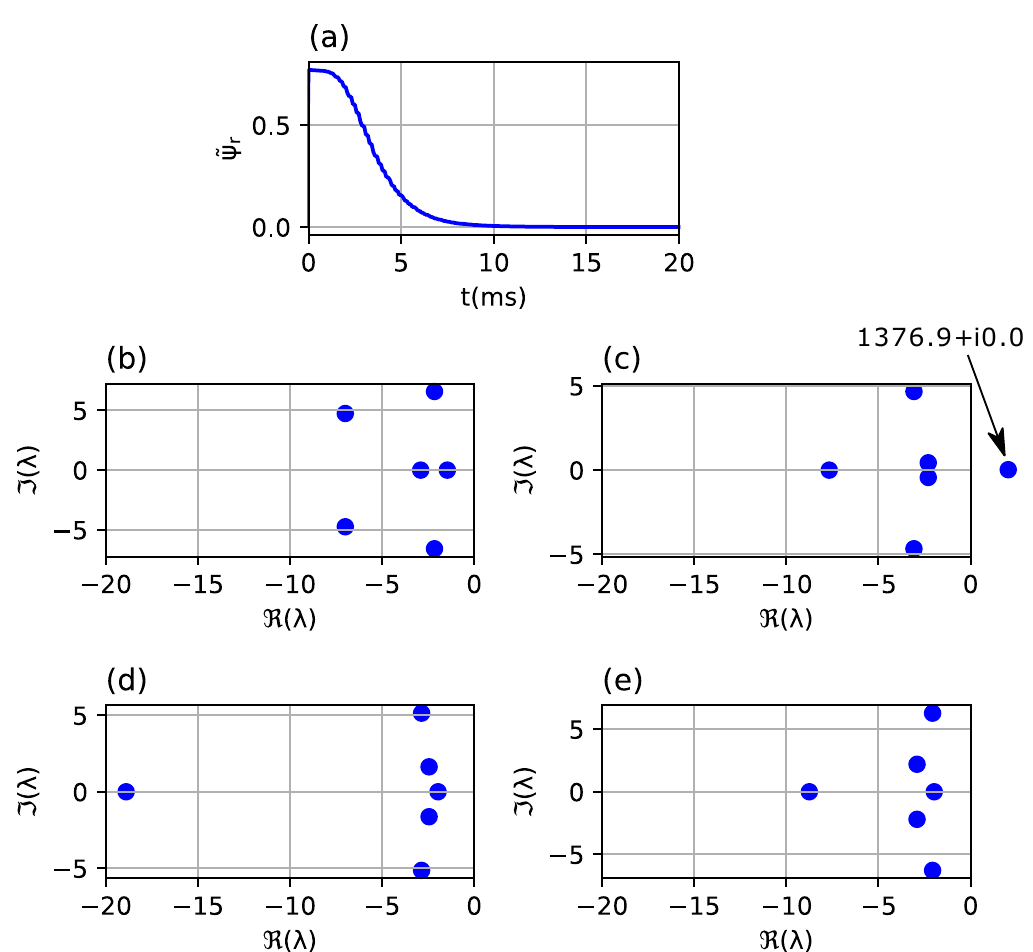
Figure 6. Sampling time influence on observer dynamics identification for order of the identified system n = 6: ( a ) impulse response of the system, ( b ) poles of the linearized system, ( c ) poles of an identified system based on signal with T s = 20 µ s, ( d ) poles of an identified system based on signal with T s = 150 µ s, ( e ) poles of an identified system based on signal with T s = 500 µ s.